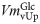
Stochastic external perturbations.Histograms of Glc, (A), and Pyr (B), and the relative standard deviations (C) of these three metabolites, at 70°C and 80°C, when VmvUpGlc changes 50% around its original value. Red bars represent the model at 70°C and green ones at 80°C.